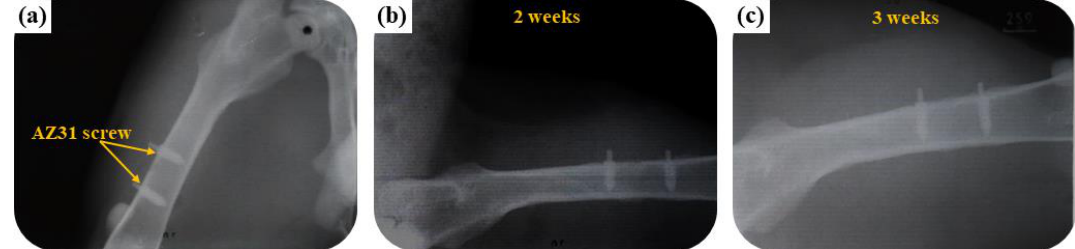
Figure 11. Plain X-ray of the AZ31 screw treated in the EDTA 7.5 g bath in the femoral shaft of a rabbit: ( a ) just implanted, ( b ) 2 weeks, and ( c ) 3 weeks.